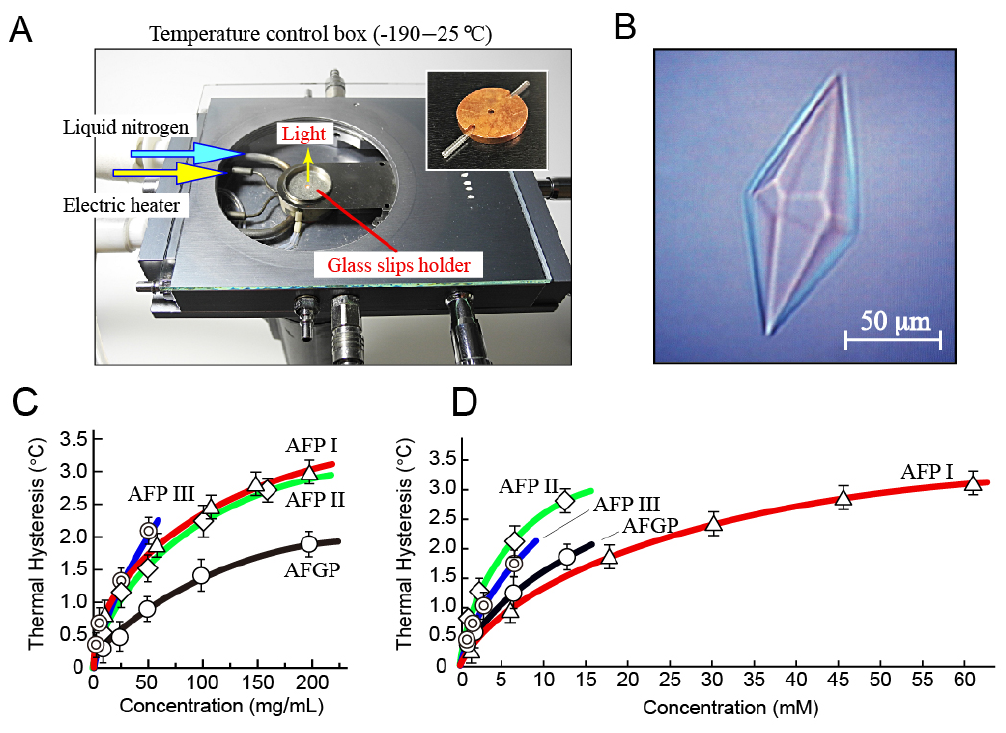
Figure 2. Thermal hysteresis evaluation for native AFP I–III and AFGP samples up to 200 mg/mL. ( A ) A temperature control box to be placed on a photomicroscope stage, which allowed observation of freezing and melting processes of a solution. Approximately 1 µL of the solution is loaded into a capillary tube soaked in a copper disk (shown in a small picture) whose temperature is manipulated on a glass slips holder with ±0.2 °C accuracy using liquid nitrogen and an electric heater. ( B ) An example of single ice crystal whose morphology was changed into a hexagonal bipyramid by AFP adsorptions. The image was observed for 0.2 mg/mL solution of AFP III. ( C ) Weight-base concentration dependence of thermal hysteresis (°C) of AFP I–III and AFGP. It was obtained for up to 50 mg/mL for AFPIII and 200 mg/mL for the others, as one single crystal was difficult to prepare above these concentrations. ( D ) Molar-base concentration dependence of thermal hysteresis (°C) of AFP I–III and AFGP. For these plots, 3,300; 14,000; 6,500; and 12,000 Da were assumed as the average molecular weights for the native AFP I–III and AFGP samples, respectively.